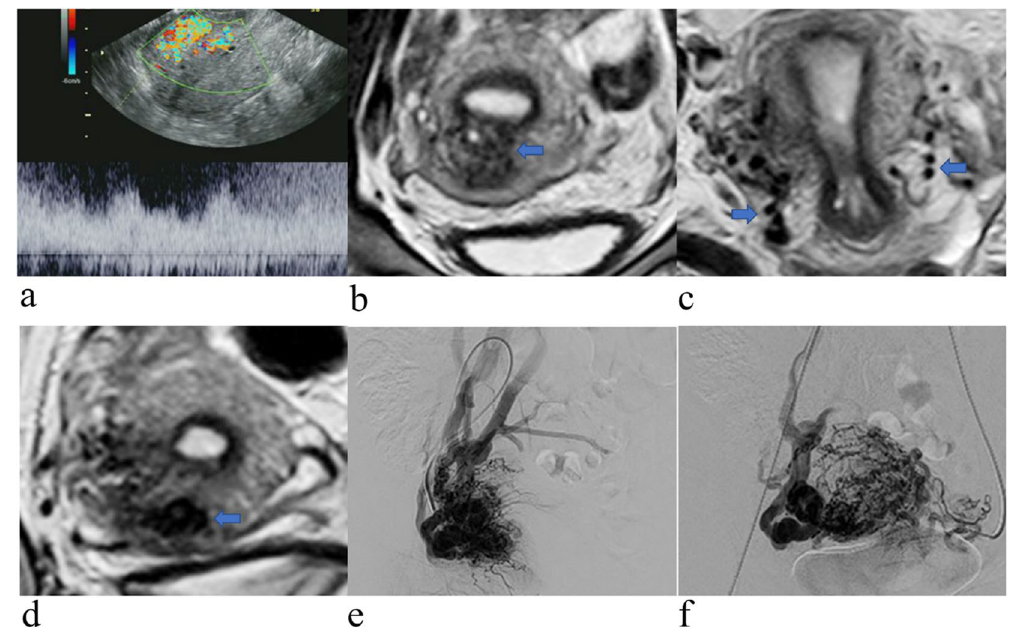
Figure 1. Images obtained of a 29-year-old woman with GTD coexisting with a uterine AVM after chemotherapy. ( a ) Colour Doppler imaging of the arteriovenous malformation within the myometrium showing brisk, highly expanded flow and pulsed Doppler imaging showing low-resistance, high-velocity flow. ( b ) Coronal T2-weighted MRI showing a mass located in the myometrium with an unclear boundary and heterogeneous signal (blue arrow). ( c ) Axial showing multiple vascular-like, irregular, serpentine flow void signs in the parametrium (blue arrow). ( d ) Coronal T2-weighted MRI showing multiple vascular-like, irregular flow void signs in the myometrium (blue arrow). ( e , f ) Pelvic angiogram of the left and right uterine arteries revealed simultaneous filling of the right draining veins in the early arterial phase, which is a definitive diagnostic finding of uterine AVMs.